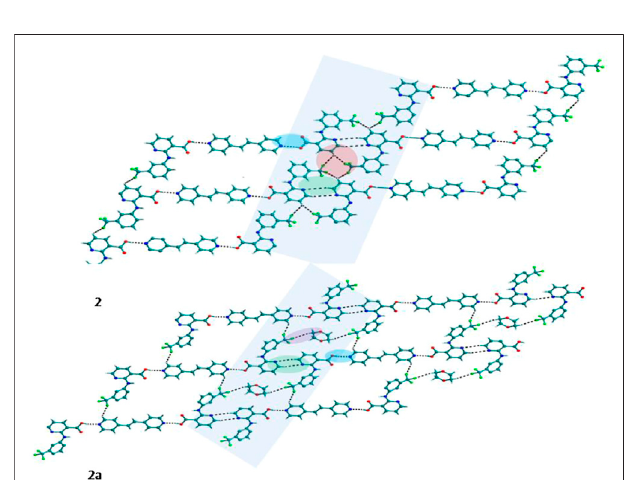
FIGURE 2 | In 2 and 2a , Nif ─ bpee ─ Nif trimers are interconnected via C ─ H ··· N and C ─ H ··· F interactions, forming a planar sheet.